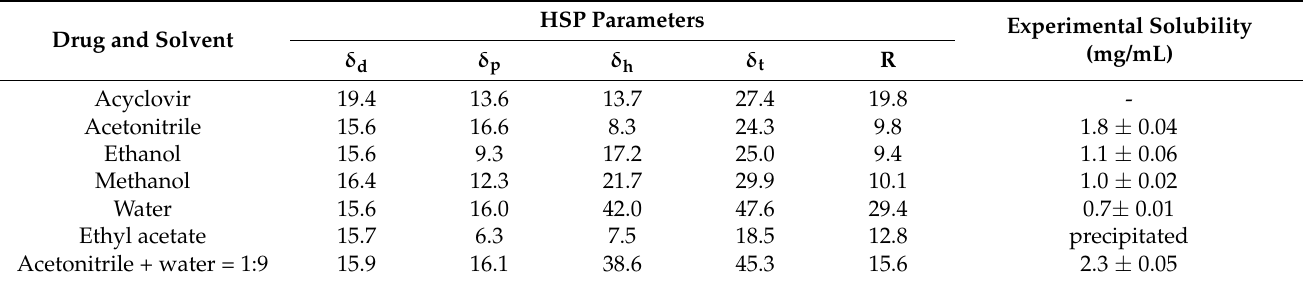
Table 4. Summary of HSP parameters for the drug, solvents, and binary mixture of “ACN + water” and experimental solubility at 30 ◦ C (R = space